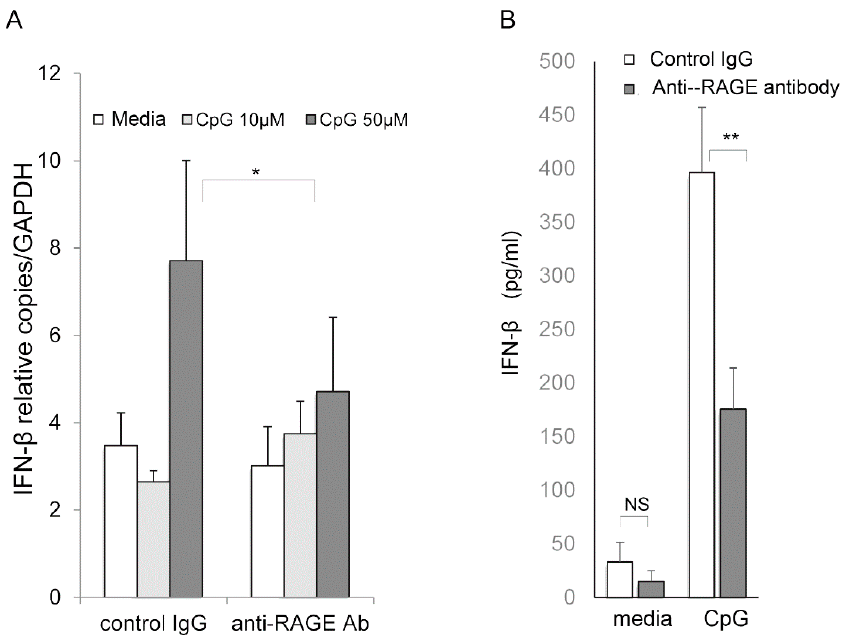
Figure 7. Role of RAGE in interferon- β production by CpG oligonucleotide stimulation of corneal endothelial cells. ( A ) HCEn cells were stimulated by CpG oligonucleotides and were assessed for interferon- β mRNA induction at 12 h by real-time RT-PCR. HCEn cells stimulated by CpG oligonucleotides significantly induced interferon- β . Inhibition by anti-RAGE antibody significantly reduced the induction of interferon- β by CpG oligonucleotide. ( B ) HCEn cells were stimulated by CpG and were assessed for interferon- β production at 24 h by ELISA. The interferon- β production by CpG oligonucleotides (50 µM) was significantly reduced by anti-RAGE antibody. n = 6, *: p = 0.01, **: p < 0.001. Ns: not significant.